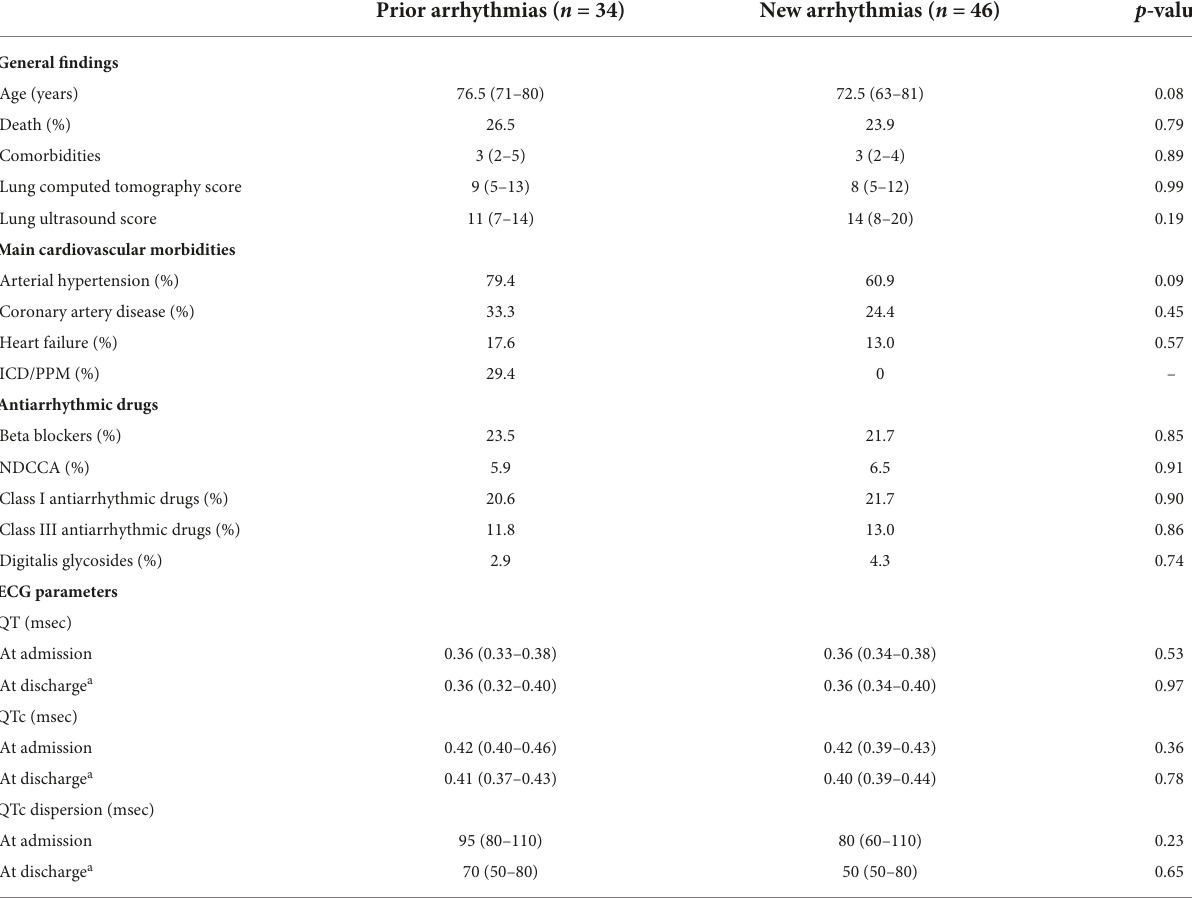
TABLE 4 General features, cardiovascular profile, antiarrhythmic treatment, and ECG measurements in the subgroups of arrhythmic patients with previously diagnosed arrhythmias and with new onset arrhythmias. Prior arrhythmias ( n = 34) New arrhythmias ( n = 46) p-